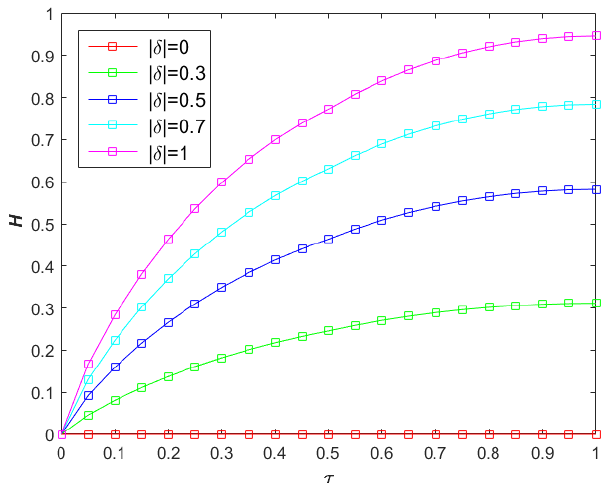
Figure 4. Dependence of polarimetric scattering entropy H on the orientation randomness τ with different values of the particle scattering anisotropy magnitude.